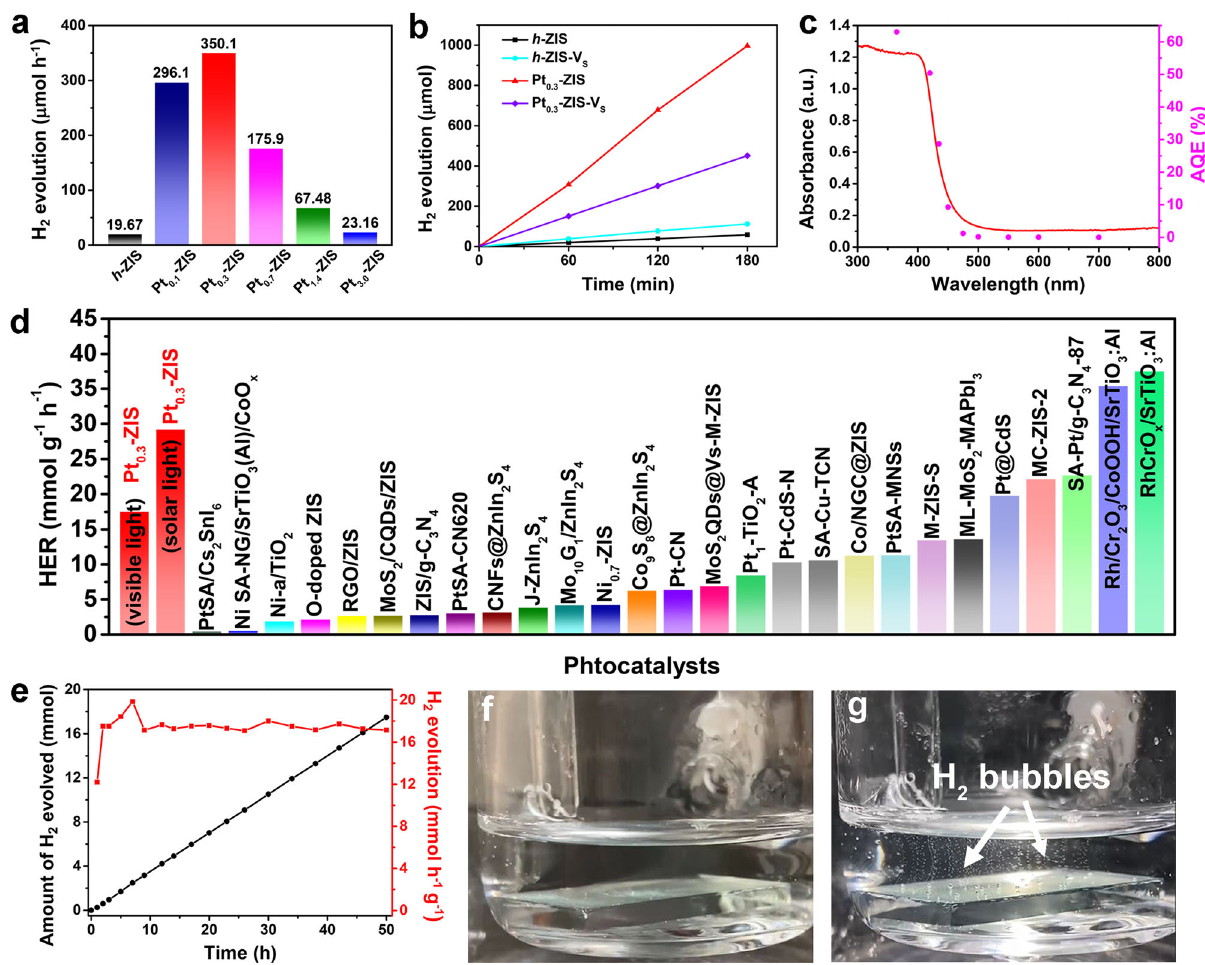
Fig. 3 Evaluation of photocatalytic HER performances. a Visible light ( λ > 420 nm) photocatalytic H 2 evolution activities of h -ZIS and Pt-ZIS with different Pt loading content. b Visible light ( λ > 420 nm) photocatalytic H 2 evolution activity of Pt 0.3 -ZIS in comparison with h -ZIS, h -ZIS-V S , and Pt 0.3 -ZIS-V S . c Wavelength dependen c e of the AQE for Pt 0.3 -ZIS. d H 2 evolution rates for Pt 0.3 -ZIS in this work compared with representative recently reported photocatalysts. e Cycling stability t e st of Pt 0.3 -ZIS. f , g Digital photograph of H 2 evolution using Pt 0.3 -ZIS fi lm without and with visible light